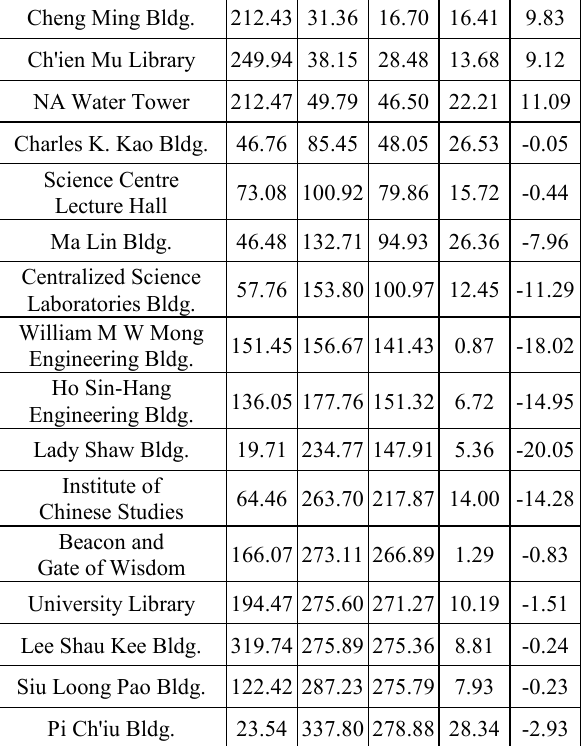
Table 2. Building Visibility Figures (Visual Distance and Angle) for the Experimental Site of Central Campus Square